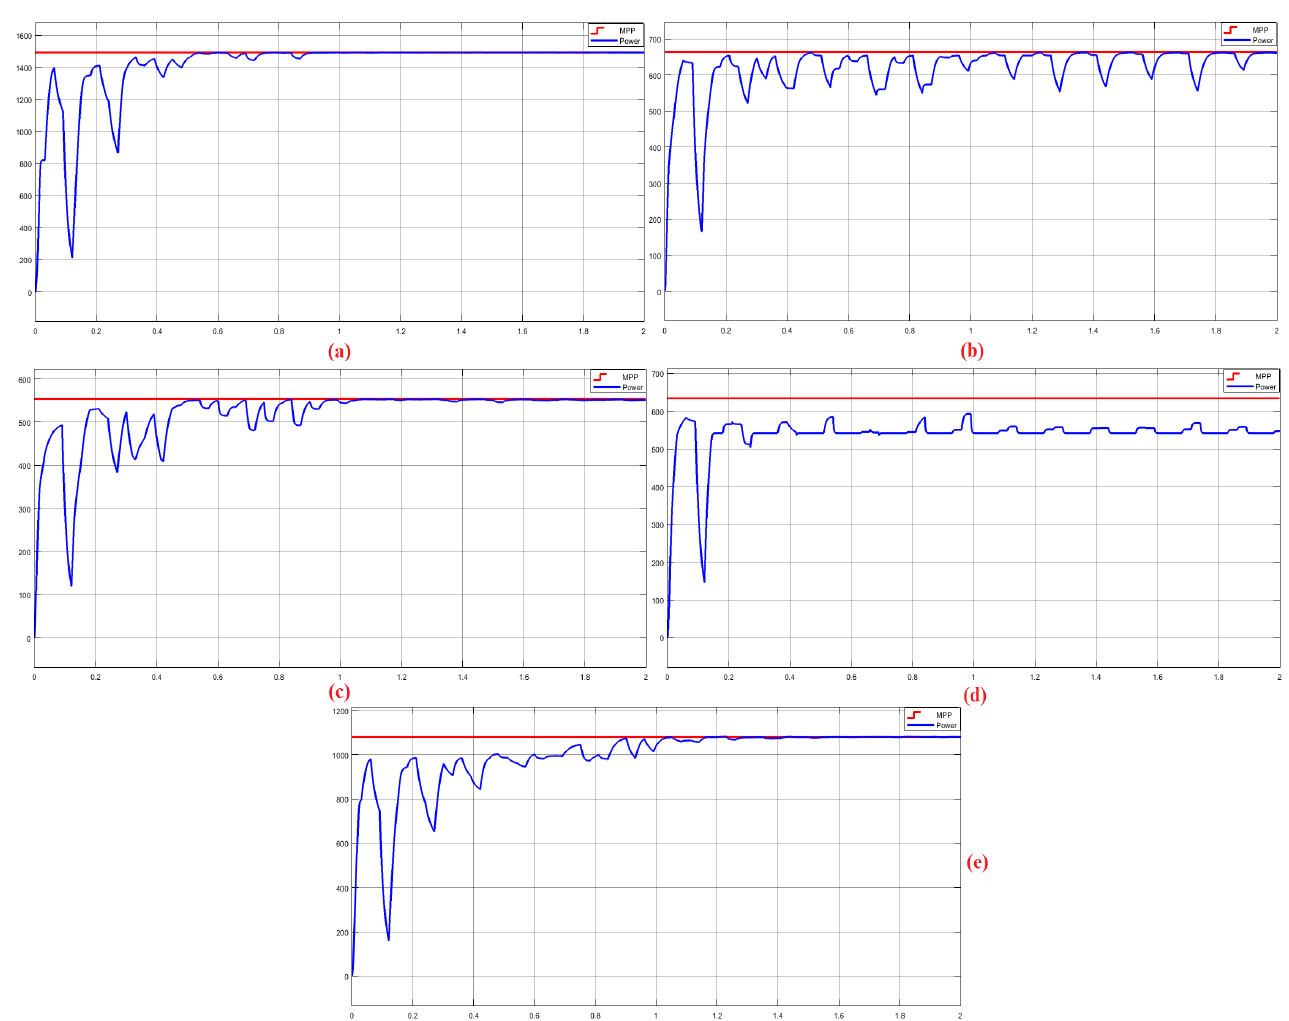
Figure 16. The power–time graph of PSO under different shading conditions. ( a ) For the UIC graph; ( b ) For the second CPSC graph; ( c ) For the third CPSC graph; ( d ) For the fourth CPSC graph; ( e ) For the fifth CPSC graph.